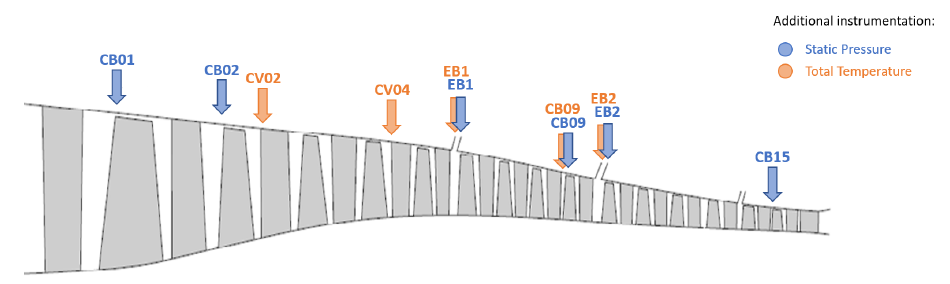
Figure 3. Meridional channel of the F-class Ansaldo Energia